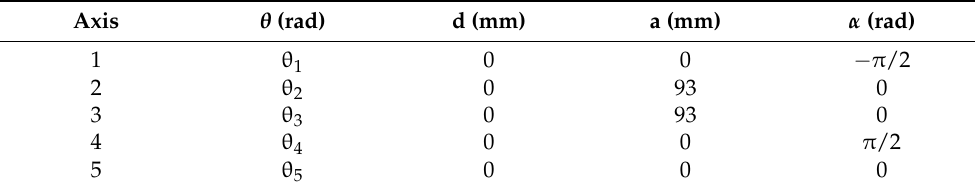
Figure 6. Representation of leg joint angles: ( a ) pitch angles, ( b ) roll angles. Table 1. D-H table of Robotis-OP2 robot